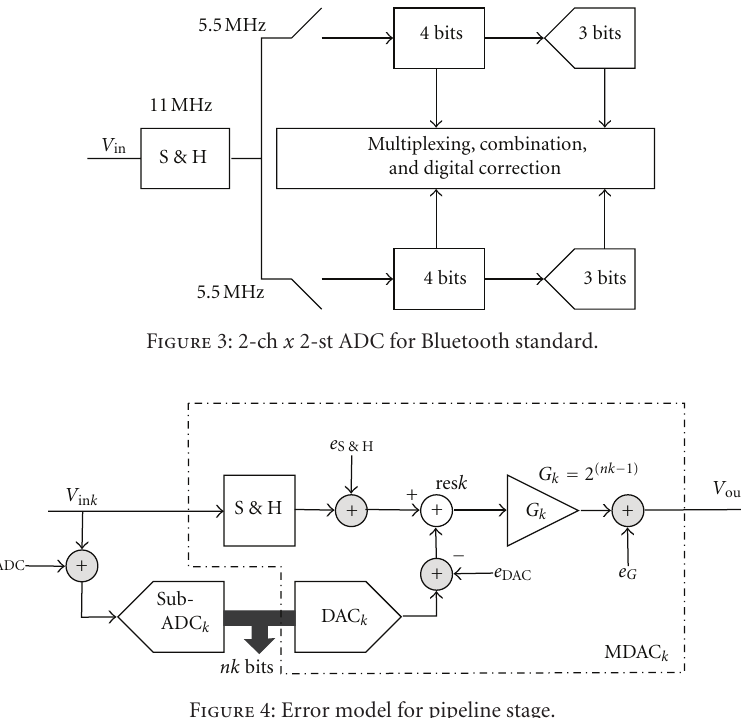
Figure 4: Error model for pipeline stage.